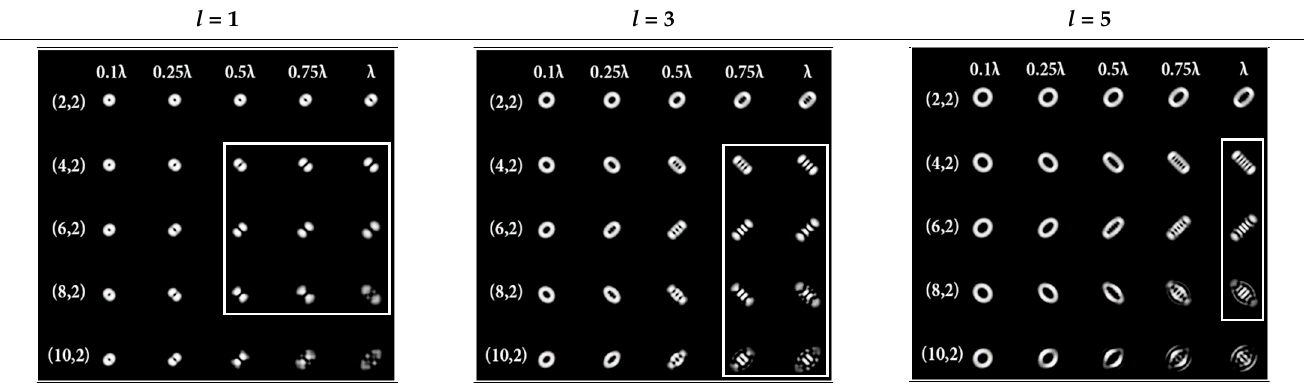
Figure 2. Amplitude ( a ) and phase ( b ) of a 25-channel amplitude-phase DOE, ( c ) the coded phase of DOE matched to different astigmatic aberrations α , intensity distribution in the focal plane ( d ) at the Gaussian beam illumination (correspondence j of aberrated PSF to diffraction orders is shown). Table 5. The action of the 25-channel DOE illuminated with vortex beams with a TC l = 1, 3, 5.